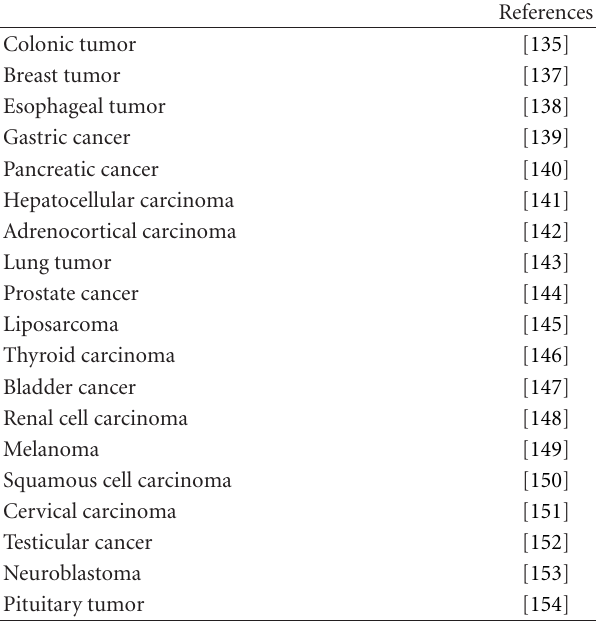
Table 2: The expression of PPAR γ in